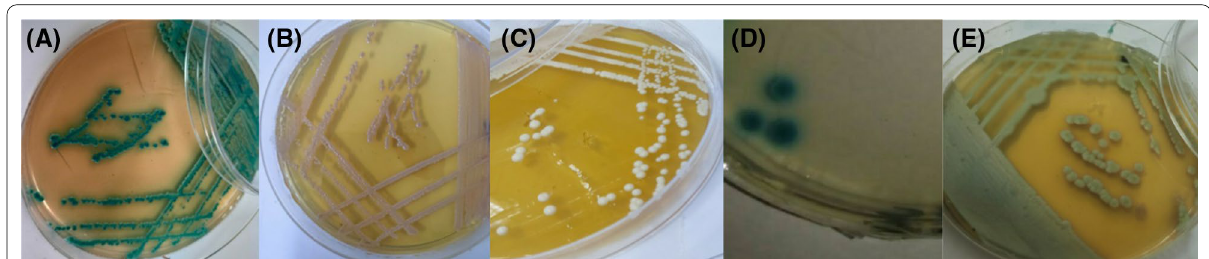
Fig. 1 CHROMagar plates, A C. albicans , B C. kruse i, C C. glabrata , D C. tropicalis and E C. parapsilosis